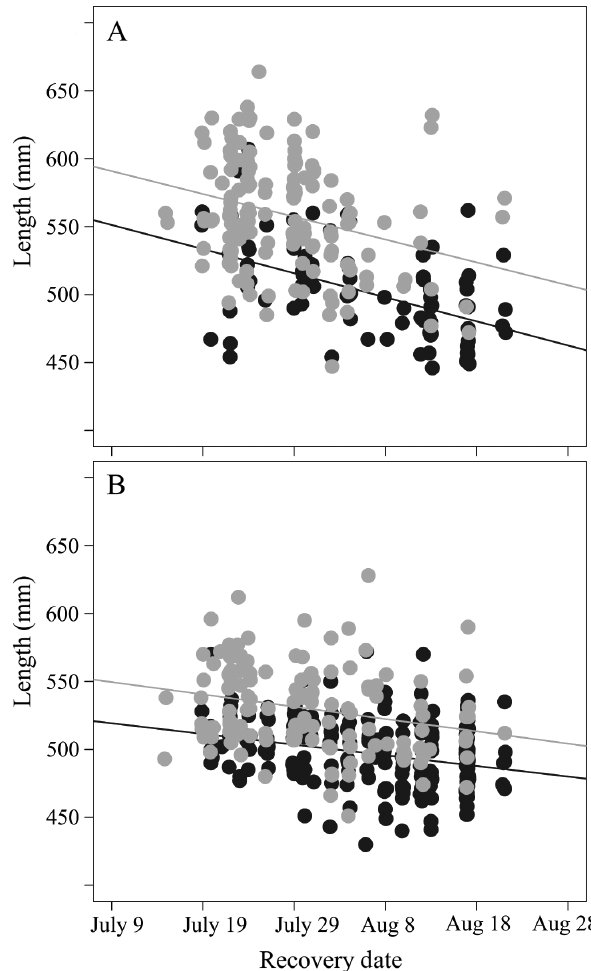
Fig. 3. Body lengths (measured from mid-eye to end of hypural plate, in mm) of (A) male and (B) female chum sal - mon by recovery date in 2015. Grey: natural-origin salmon; black: hatchery-produced salmon. Solid lines: simple linear regressions through